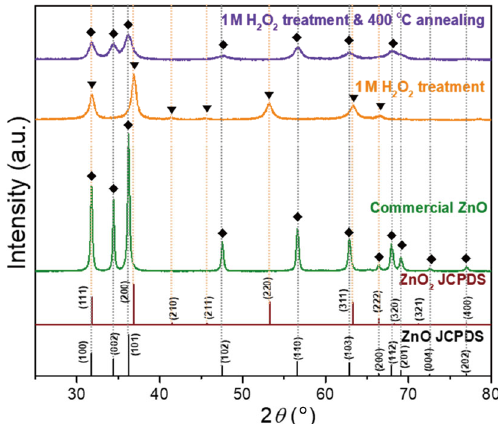
Fig. 1 XRD patterns of commercial ZnO, 1 M H 2 O 2 treated ZnO, and 1 M H 2 O 2 treated/annealed ZnO. Standard XRD patterns of hexagonal wurtzite ZnO (JCPDS No. 36- 1451) and cubic ZnO 2 (JCPDS No. 76-1364) are shown as vertical lines at the bottom.